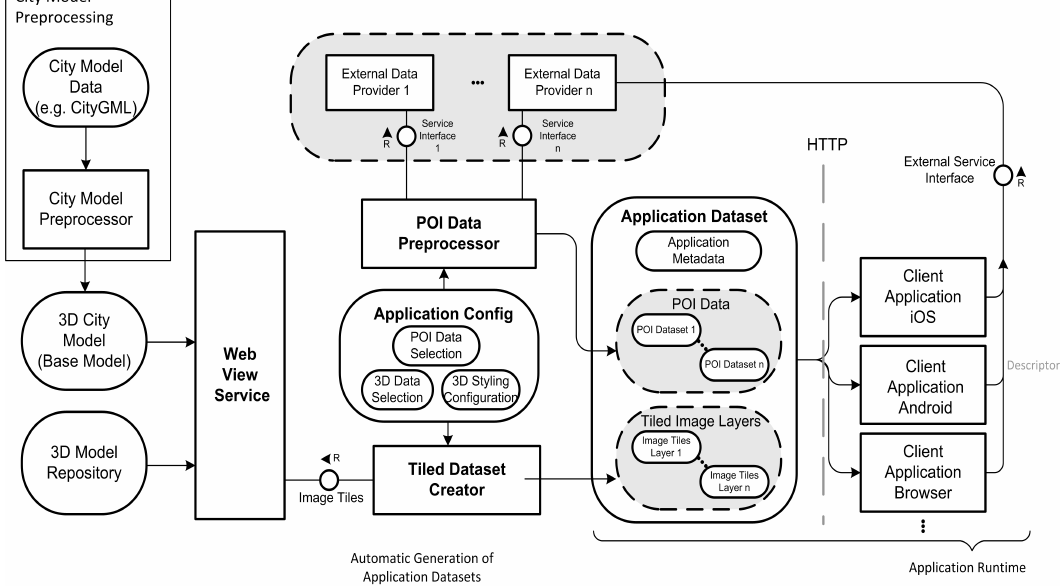
Figure 2: An overview of the system for automated generation of application datasets from different data sources as FMC block diagram 5 . 3D city models where imported in a render optimized form into the rendering service. Application datasets, that define contents (oblique map tiles, POI data, and external service URLs to be used) and behavior (e.g., which url to load on tap for POI items) are generated for being consumed by client